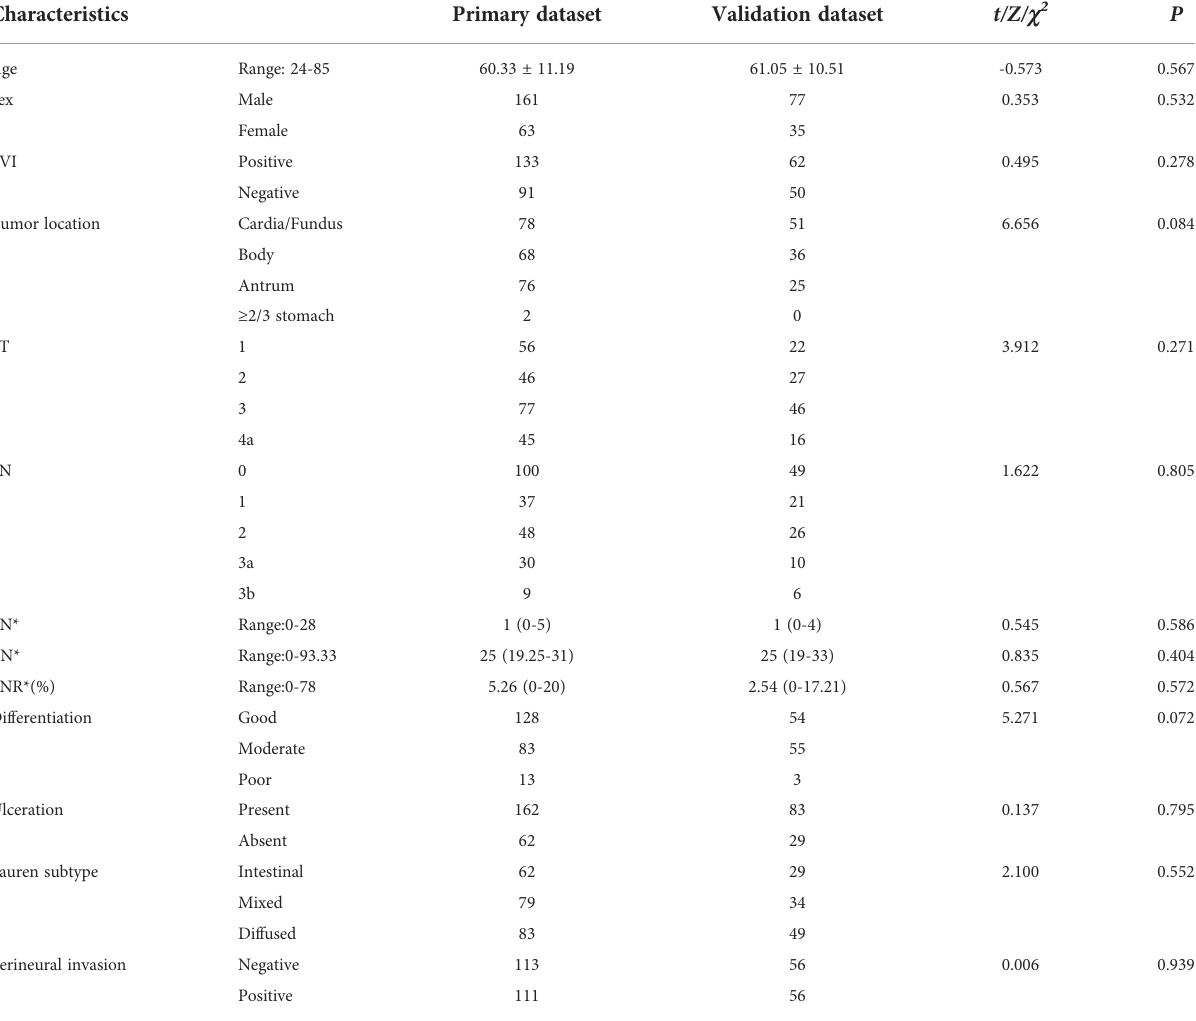
TABLE 1 Patients background characteristics between primary dataset and validation